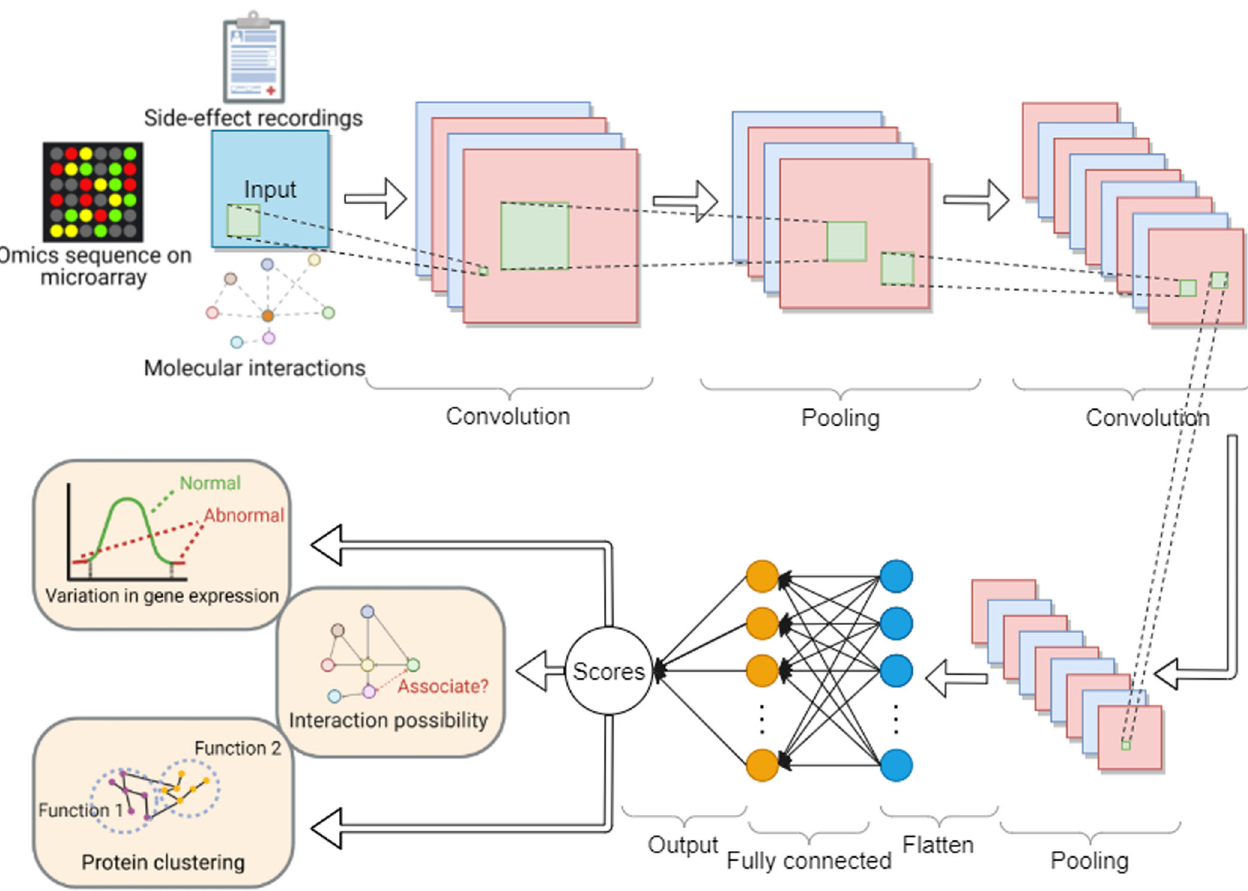
Fig. 5 A convolutional neural network. This neural network is comprised of an input layer, convolutional layers (that extract features from hyperplanes of input data by projection/convolution), pooling layers (that reduce the spatial size and mitigate the locational sensitivity), fl atten layer (that fl attens the features and feeds them into the arti fi cial neural network), fully connected layer (that learns nonlinear function of the extracted features) and an output layer. The input is the raw features such as molecules sequence patterns, gene regulation annotations and patterns, molecular interaction network motifs, molecular structures and structural associations, drug chemical structures, drug side-effect reports, and so on. The output can be the predicted classi fi cation (e.g., molecular binding pro fi les) and regression (e.g., quanti fi ed molecular binding af fi nities) when obtaining new